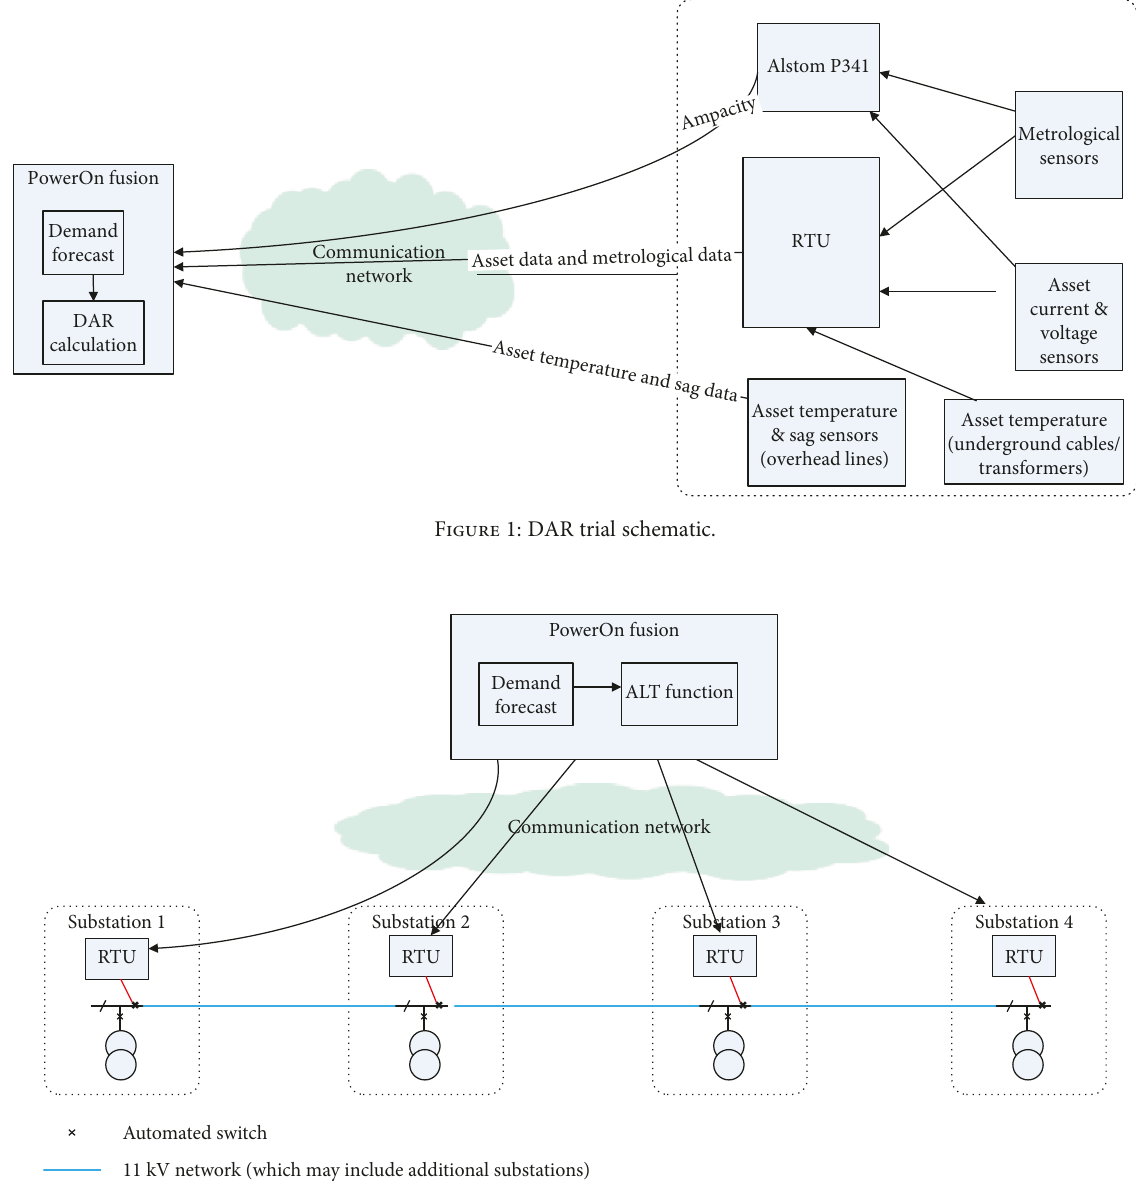
Figure 2: ALT trial